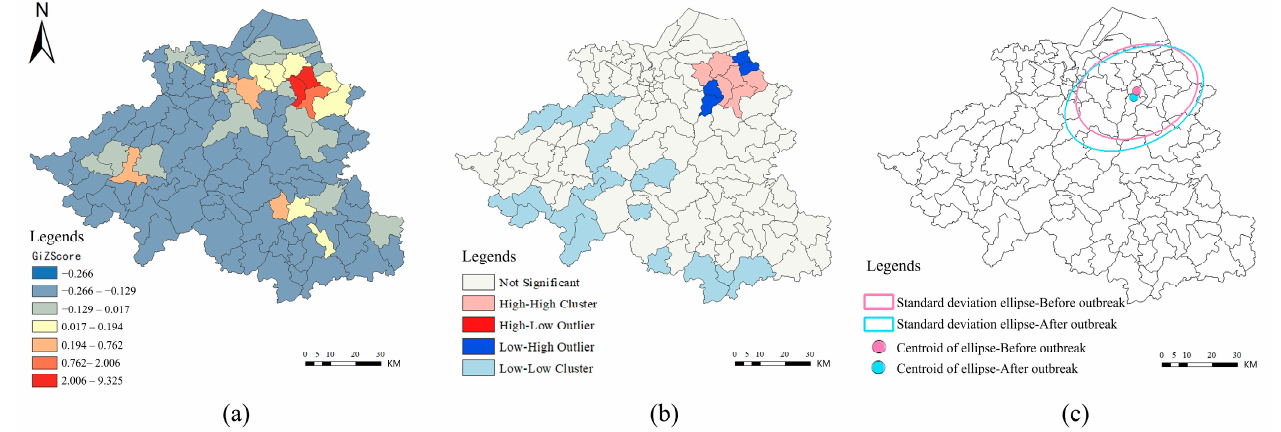
Figure 5. Analysis of the spatial-temporal characteristics of the distribution of confirmed COVID-19 cases in Shaoxing: ( a ) Gi-ZScore hot-spot analysis; ( b ) Clustering and outlier analysis—local Moran’s I, and ( c ) Standard deviation ellipse analysis.